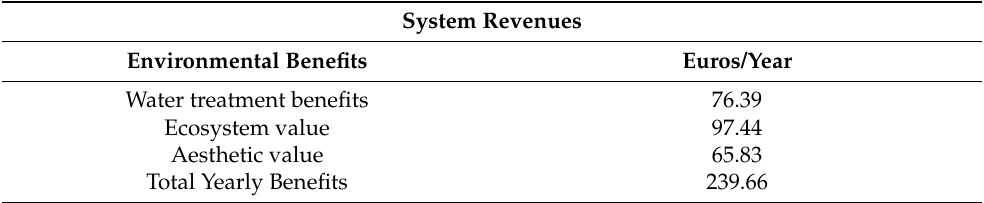
Table 7. Evaluation of yearly system revenues in terms of environmental benefits.